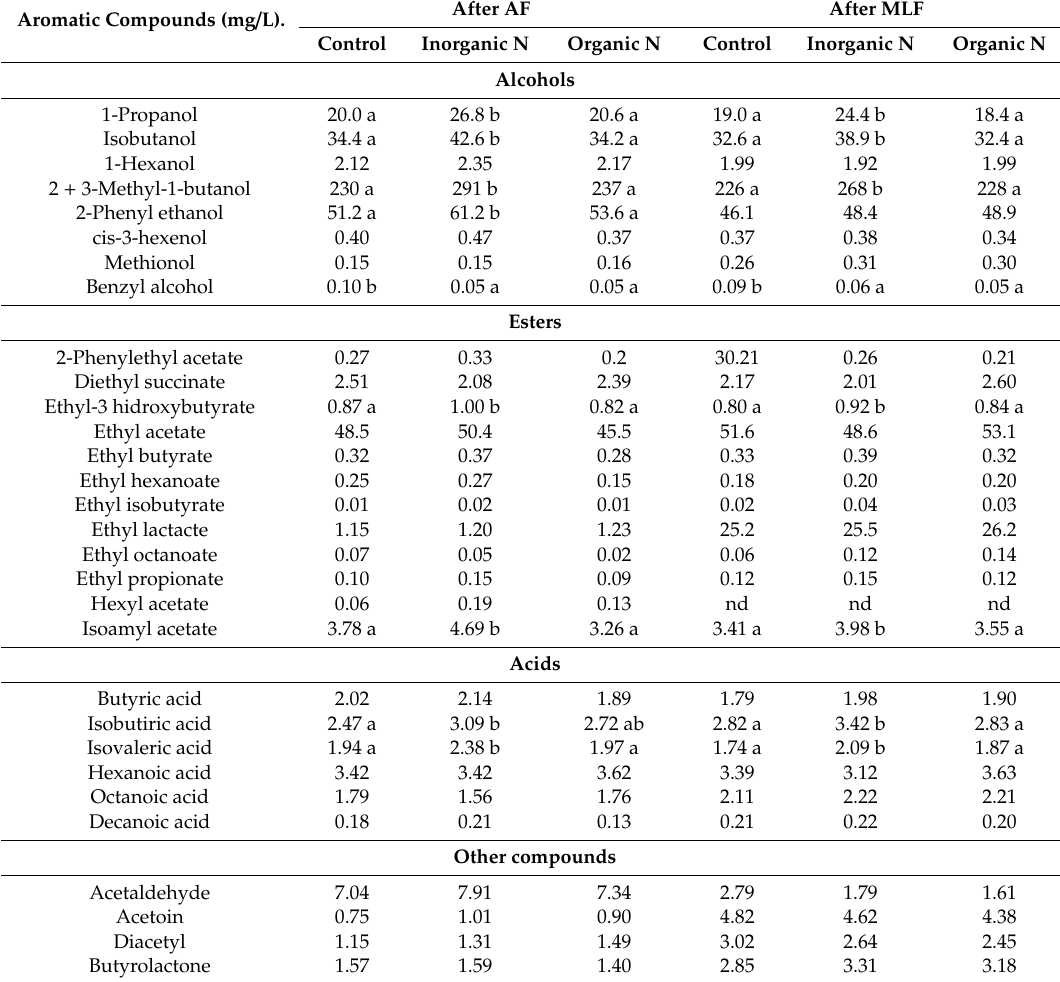
Table 2. Average values of aromatic compounds of the wines after AF and MLF with di ff erent nitrogen additions. Aromatic Compounds (mg /